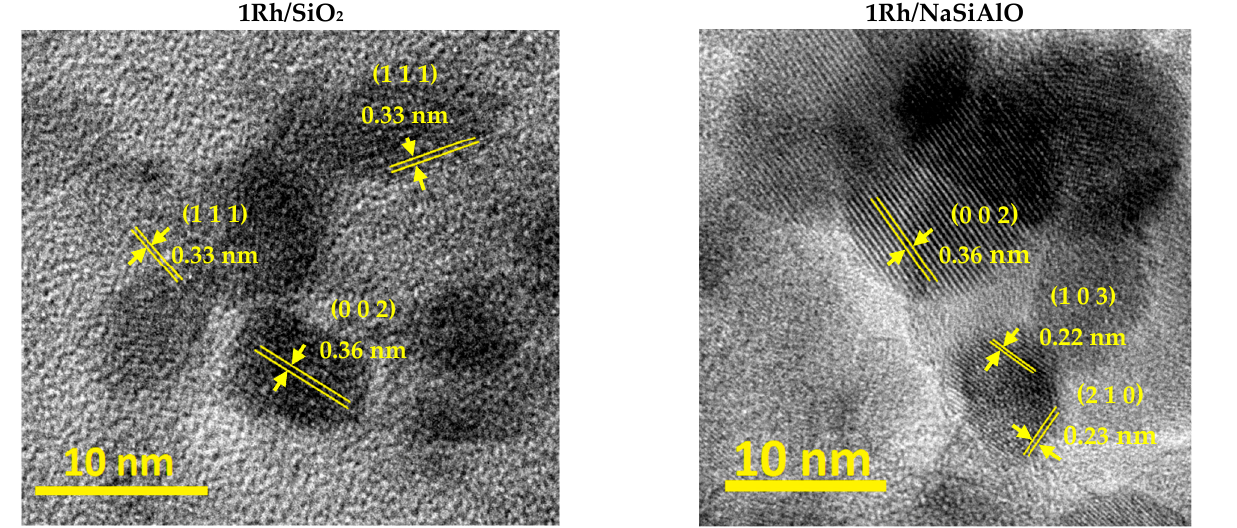
Figure 5. TEM images of the initially calcined in air catalysts with Si-containing supports. The crystal planes are indicated in the pictures.